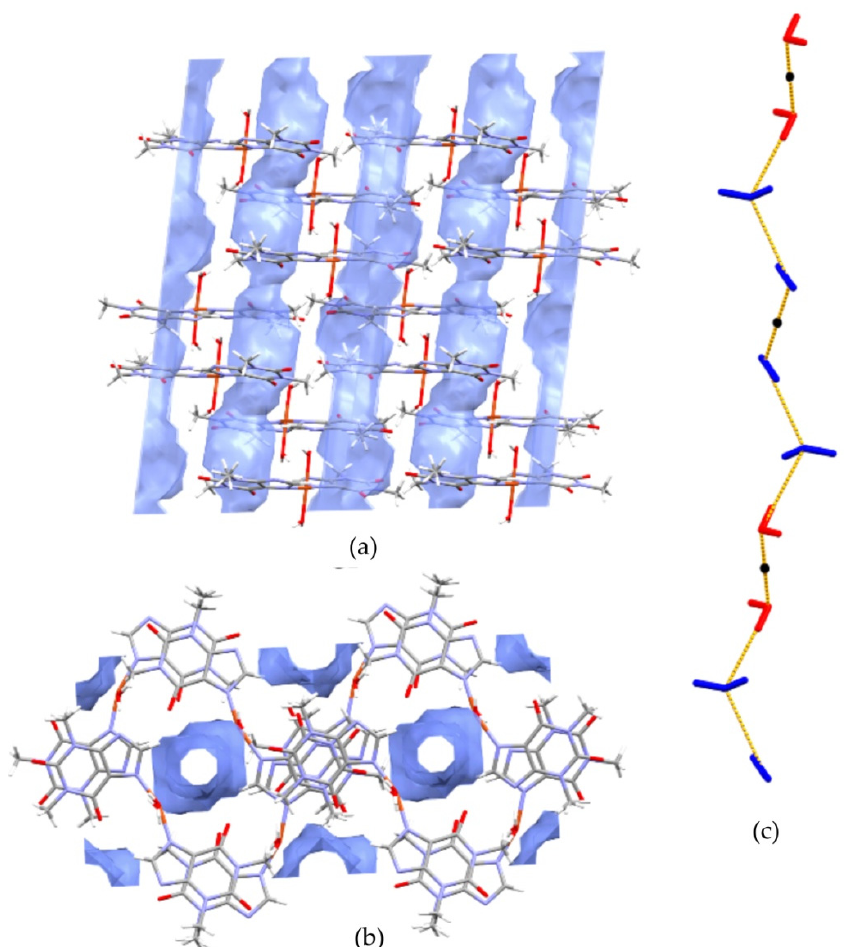
Figure 5. The channels occupied by water molecules in the crystal of 1 as drawn along the b axis ( a ) and the a axis ( b ). Void volumes are based on contact surface as calculated by Mercury, with a grid step of 0.7 Å and a probe radius of 1.2 Å. Infinite chains propagated along [100] direction are constituted of non coordinated (blue) and coordinated (red) water molecules associated through hydrogen bonds ( c ). Black dots indicate symmetry centres.